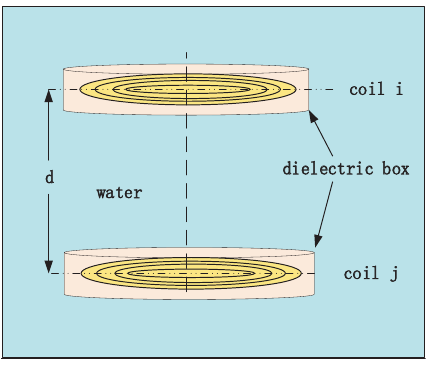
Figure 1. Schematic diagram of coils immersed in water.